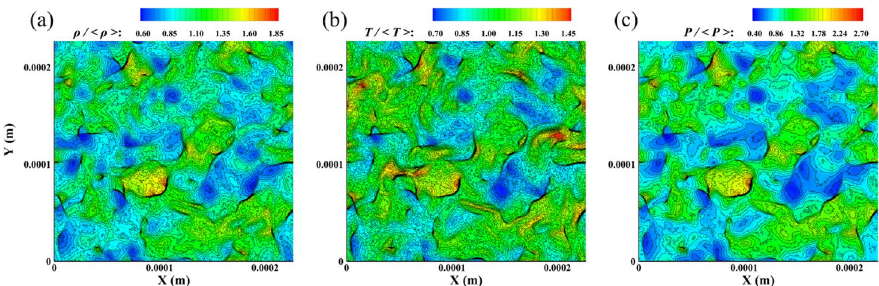
ρ (a), normalized temperature T / (cid:31) (cid:30)